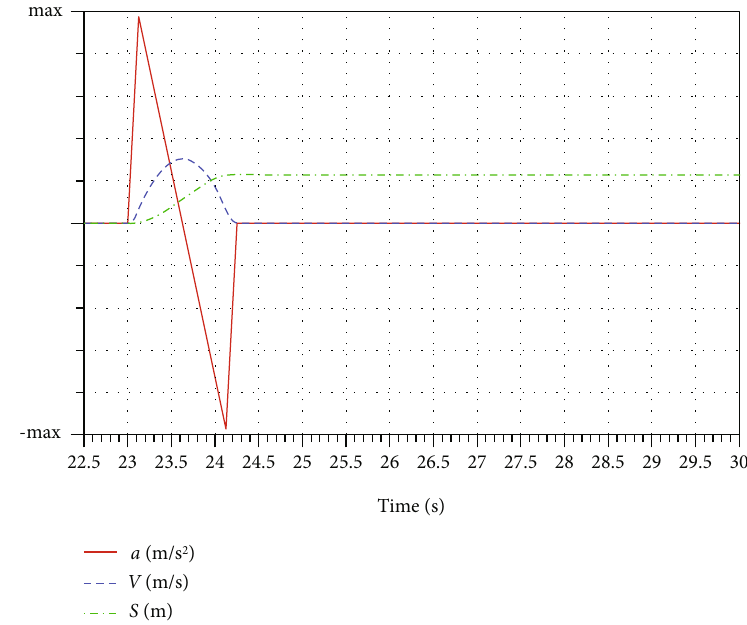
Figure 4: Drogue acceleration, velocity, and displacement characteristics. Table 3: Cases for the veri fi